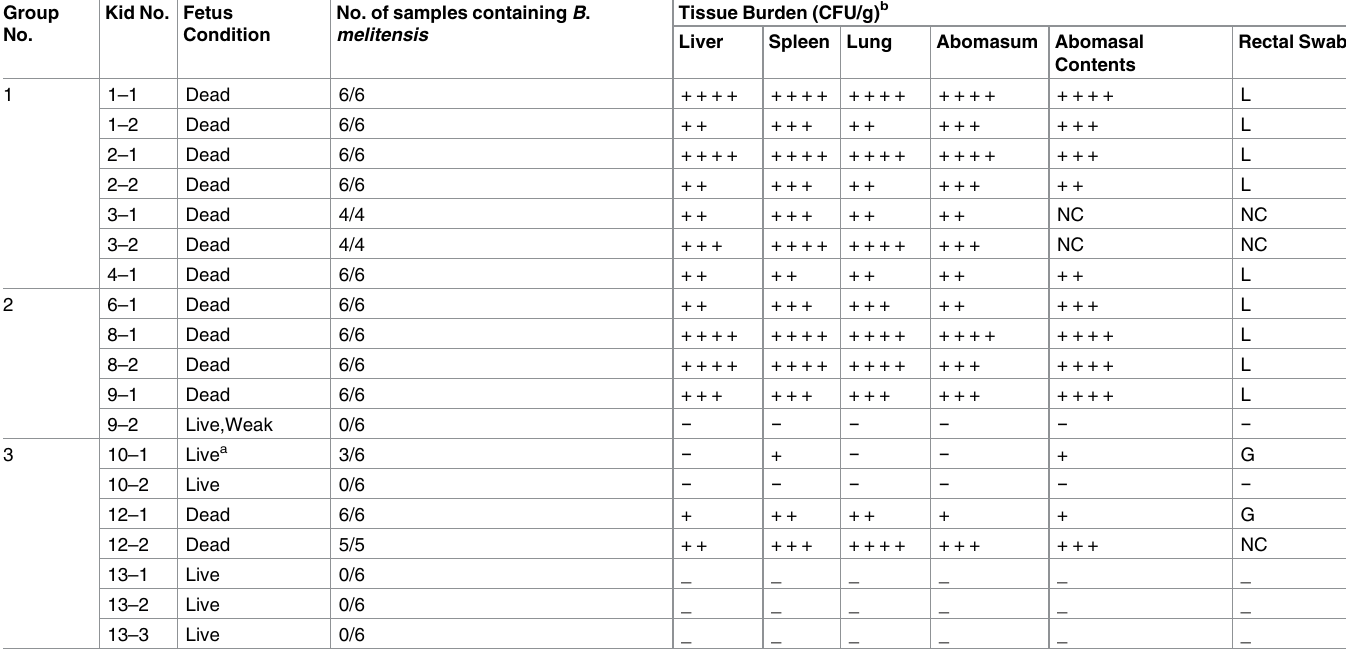
Table 3. Isolation of B . melitensis 16M and Rev. 1 from fetal tissues at time of parturition. Group